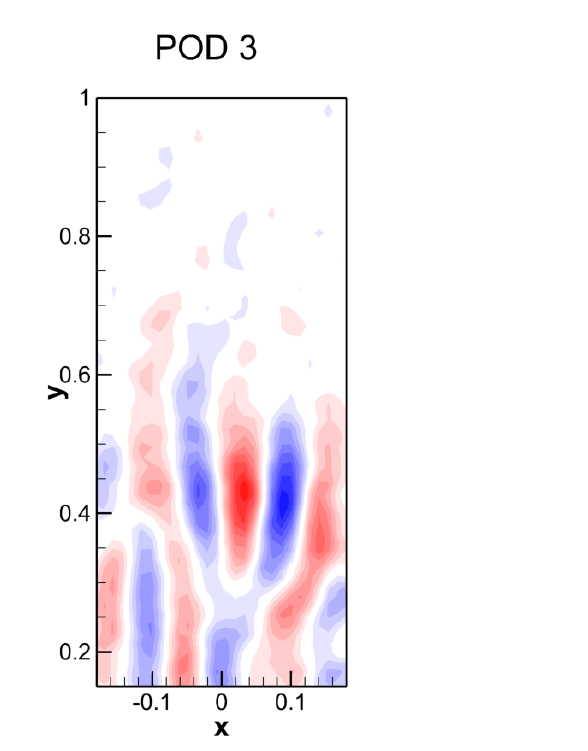
Fig. 18. Vorticity POD mode No. 3, 1% TE.